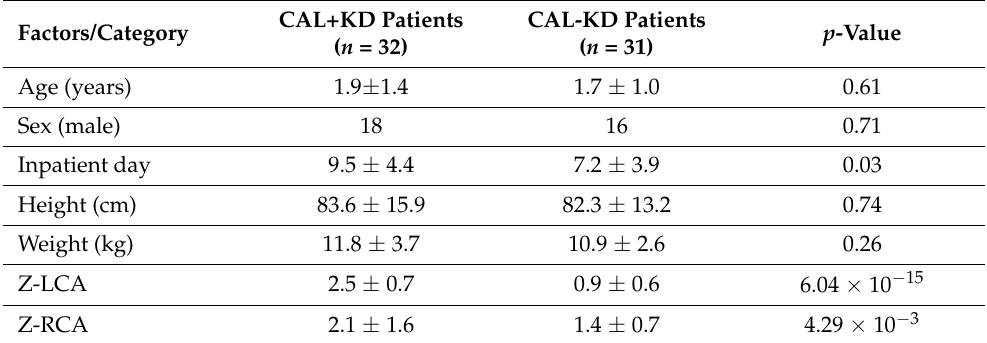
Table 1. Demographic data of subjects.